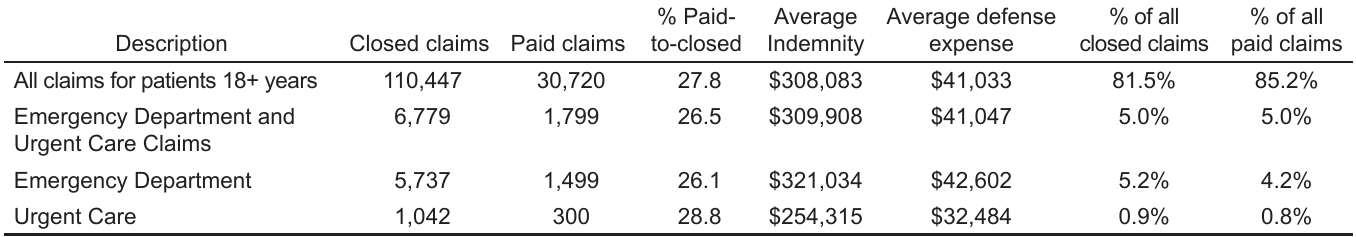
Table 1. Summary of claims submitted to the Data Sharing Project of the Medical Professional Liability Association during a 15-year period (2001-2015).